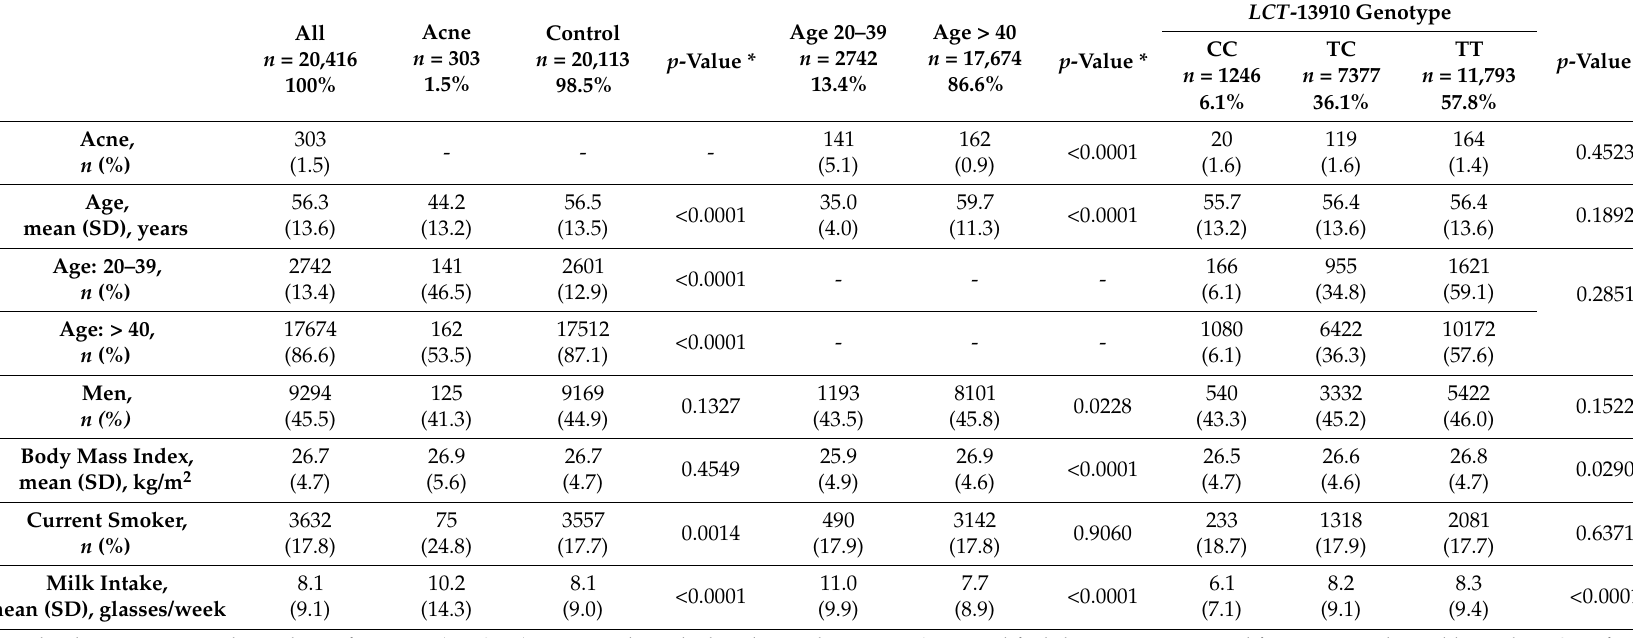
Table 1. Baseline characteristics for The Danish General Suburban Population study (GESUS) by acne, age groups, and LCT-13910